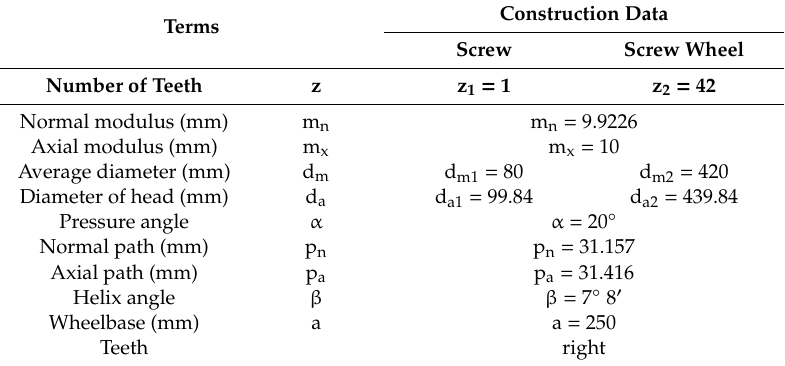
Table 2. Constructive data.